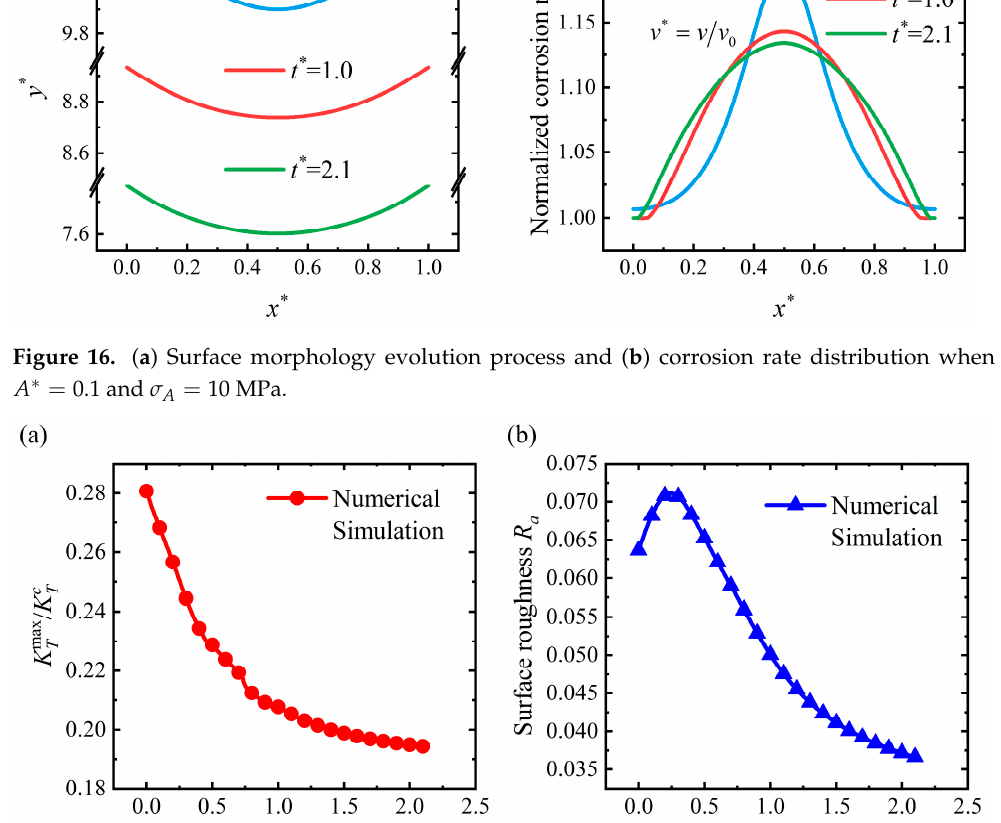
Figure 19. Surface morphology evolution process when